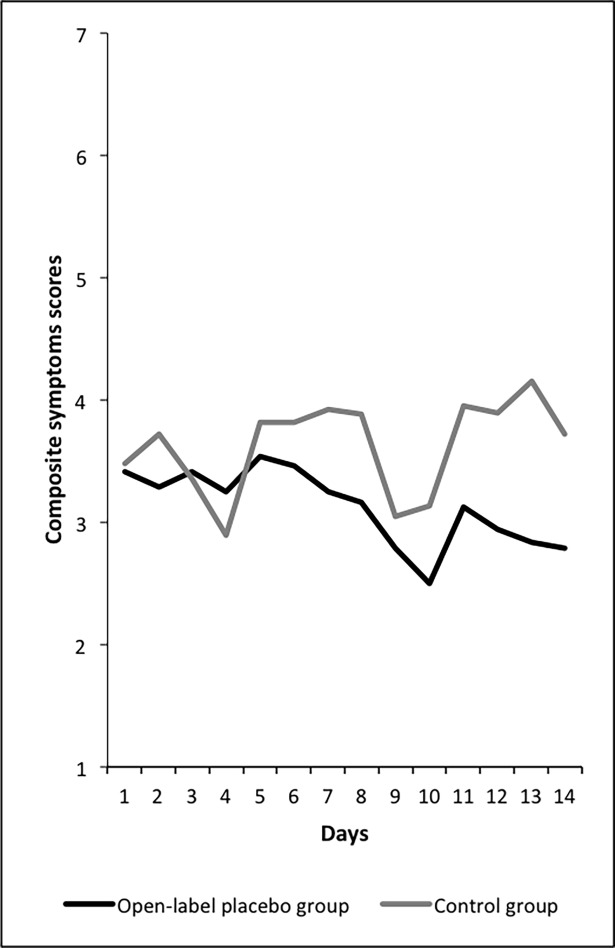
Data of the allergic diary demonstrate improvement of the open-label placebo group over time.